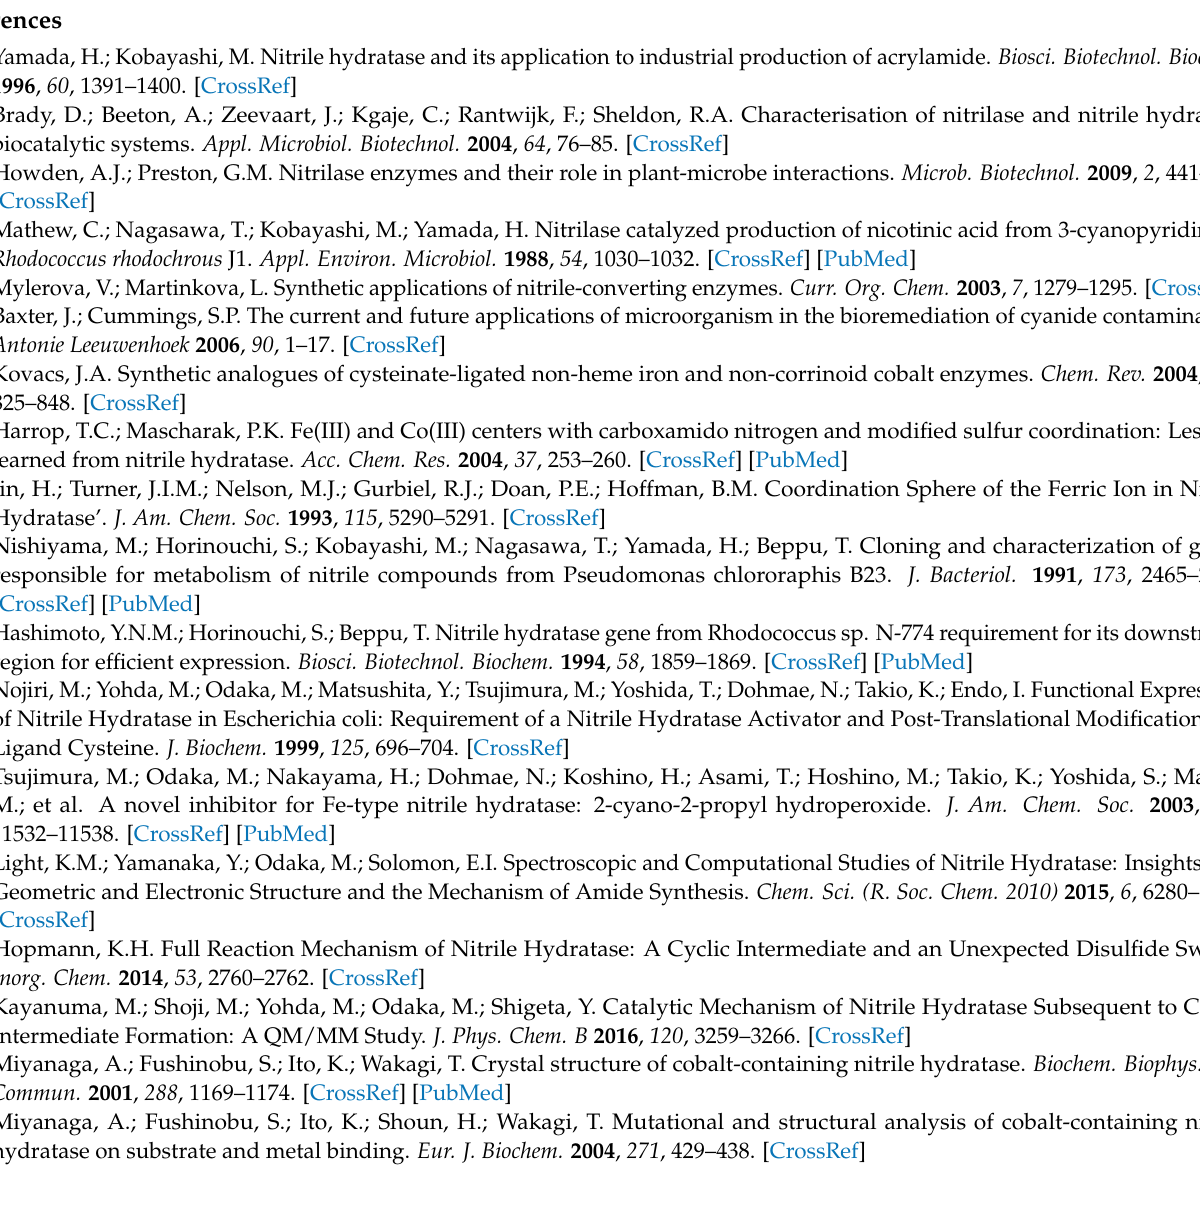
Figure S2: Michaelis-Menten graphs for Pt NHase protein